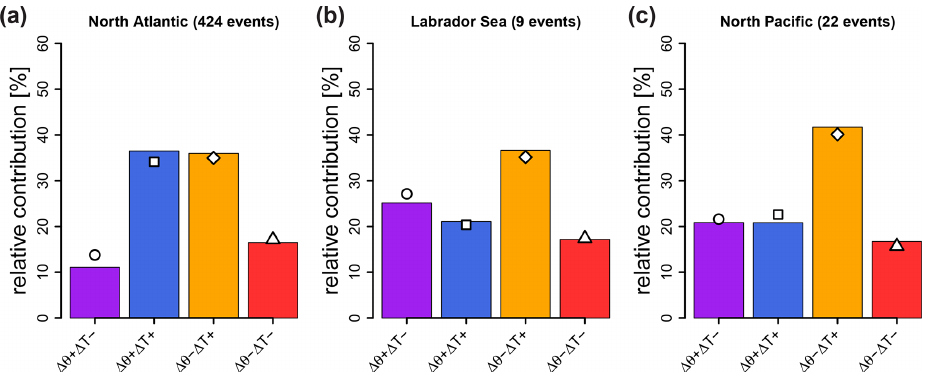
Figure 6. Relative contributions of trajectory categories to meridional moisture transport associated with moist-air intrusions in (a) the North Atlantic, (b) the Labrador Sea, and (c) the North Pacific. Symbols indicate the percentage of trajectories in each of the